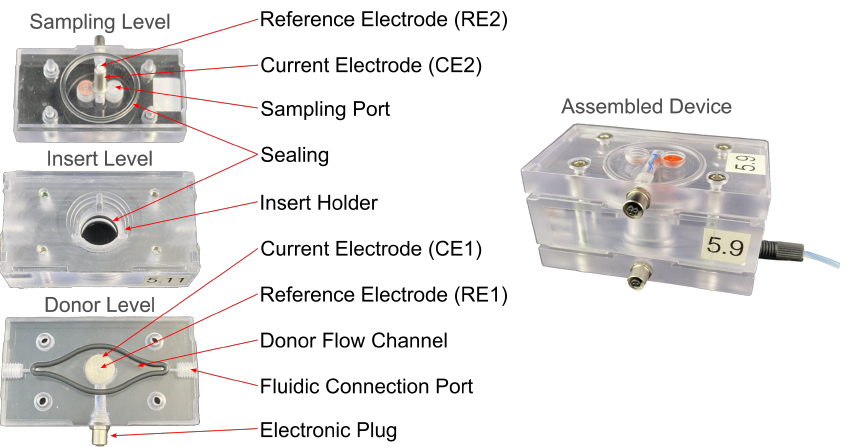
Figure 1. Photo of the fluidic device levels and the assembled device. Outer dimensions: w = 7.3cm, l = 4.0cm, h =